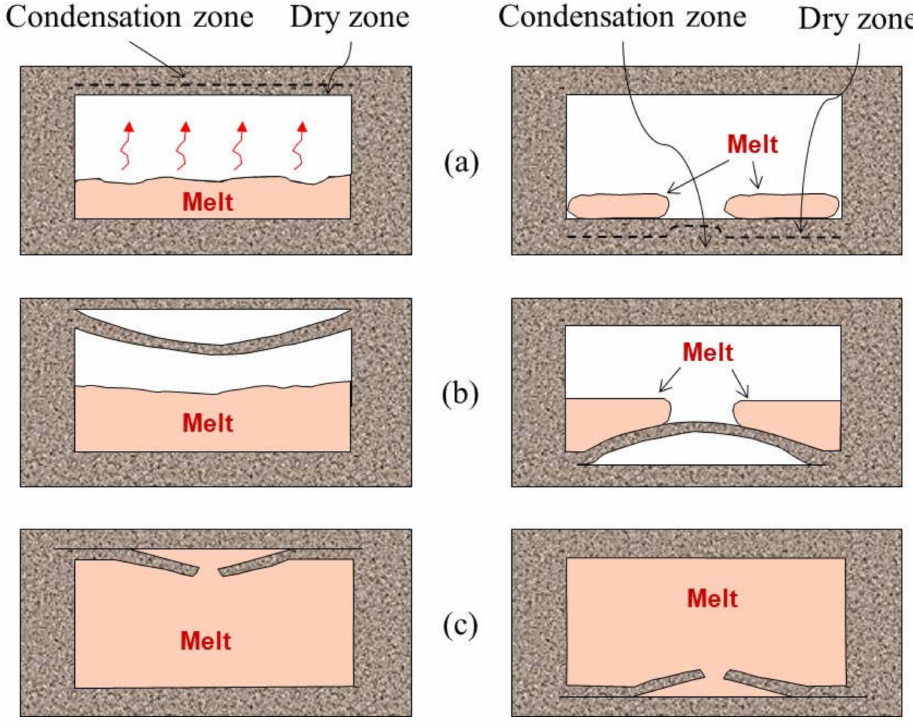
Figure 24. Different steps ( a – c ) in the formation mechanism of a common roof scab ( left column) and a floor scab ( right